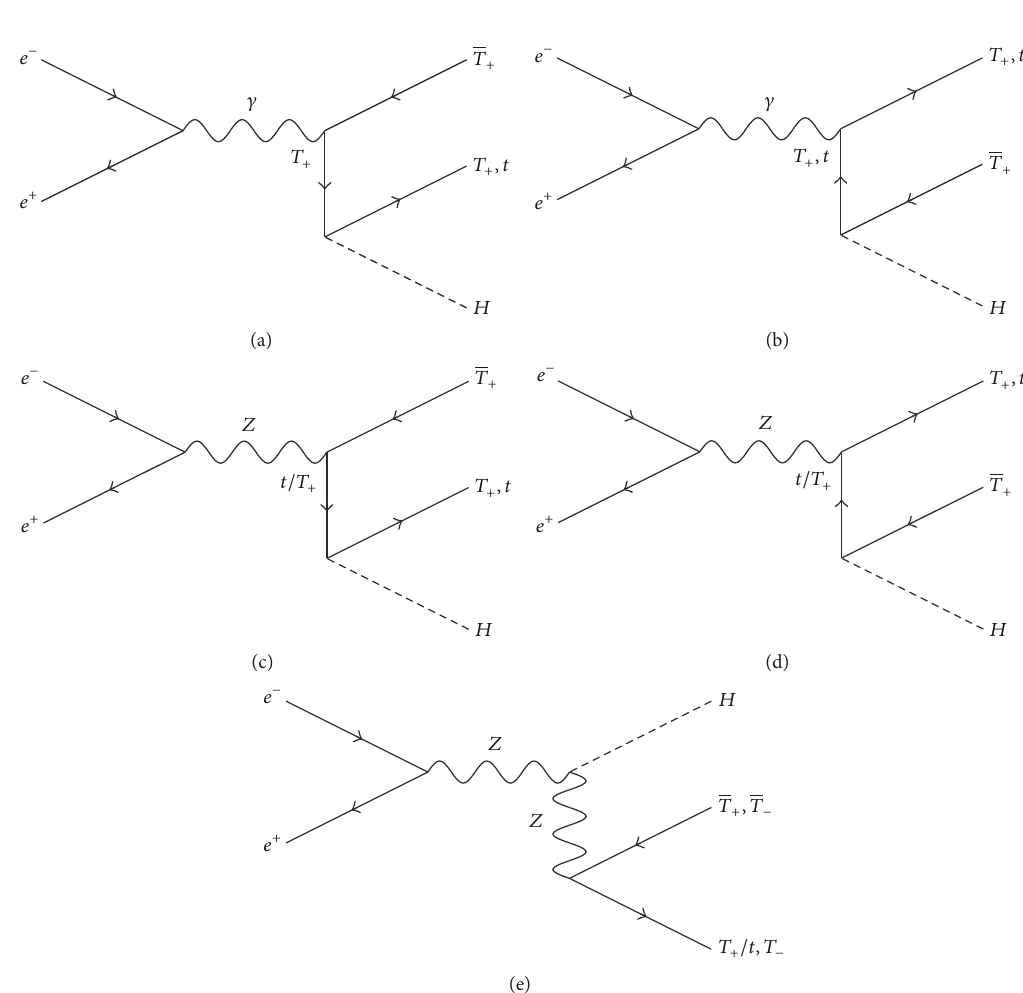
Figure 2: Feynman diagrams of the Higgs and top partner associated production at 𝑒 + 𝑒 −